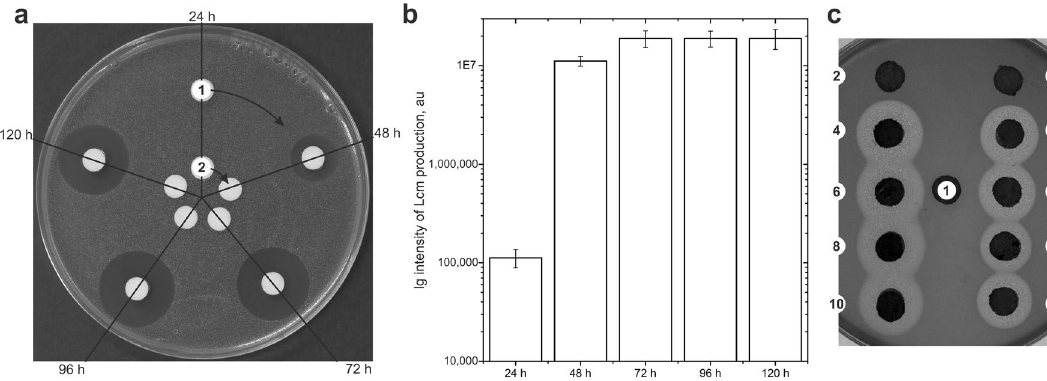
Figure 2. Antifungal activity of S. cyanogenus ΔlanI7 pGM4181 + as a function of cultivation time ( a , b ) and origin of adpA gene ( c ). For D. hansenii growth inhibition assay ( a ) the extracts were prepared from YMPG- grown ΔlanI7 pGM4181 + (1) and ΔlanI7 (2) at timepoints shown in the figure. The initial strain ΔlanI7 (2) showed no activity at all investigated time points. LC–MS quantification of the Lcm mass peak in the same extracts ( b ) was in agreement with the results of the bioassay. Data represent mean values of three independent experiments ± 2SD. ( c ) D. hansenii growth inhibition assay showing that adpA genes (and corresponding DNA- binding domains, DBD), other than XNR_4181, were able to activate Lcm production in S. cyanogenus ΔlanI7: (4,5)—ΔlanI7 pGMSCO + and pGMSCOd + , overexpressing S. coelicolor adpA and its DBD, respectively; (6,7)— ΔlanI7 pGMSCLA + and pGMSCLAd + , S. clavuligerus adpA and its DBD, respectively; (8,9)—ΔlanI7 pGM4181